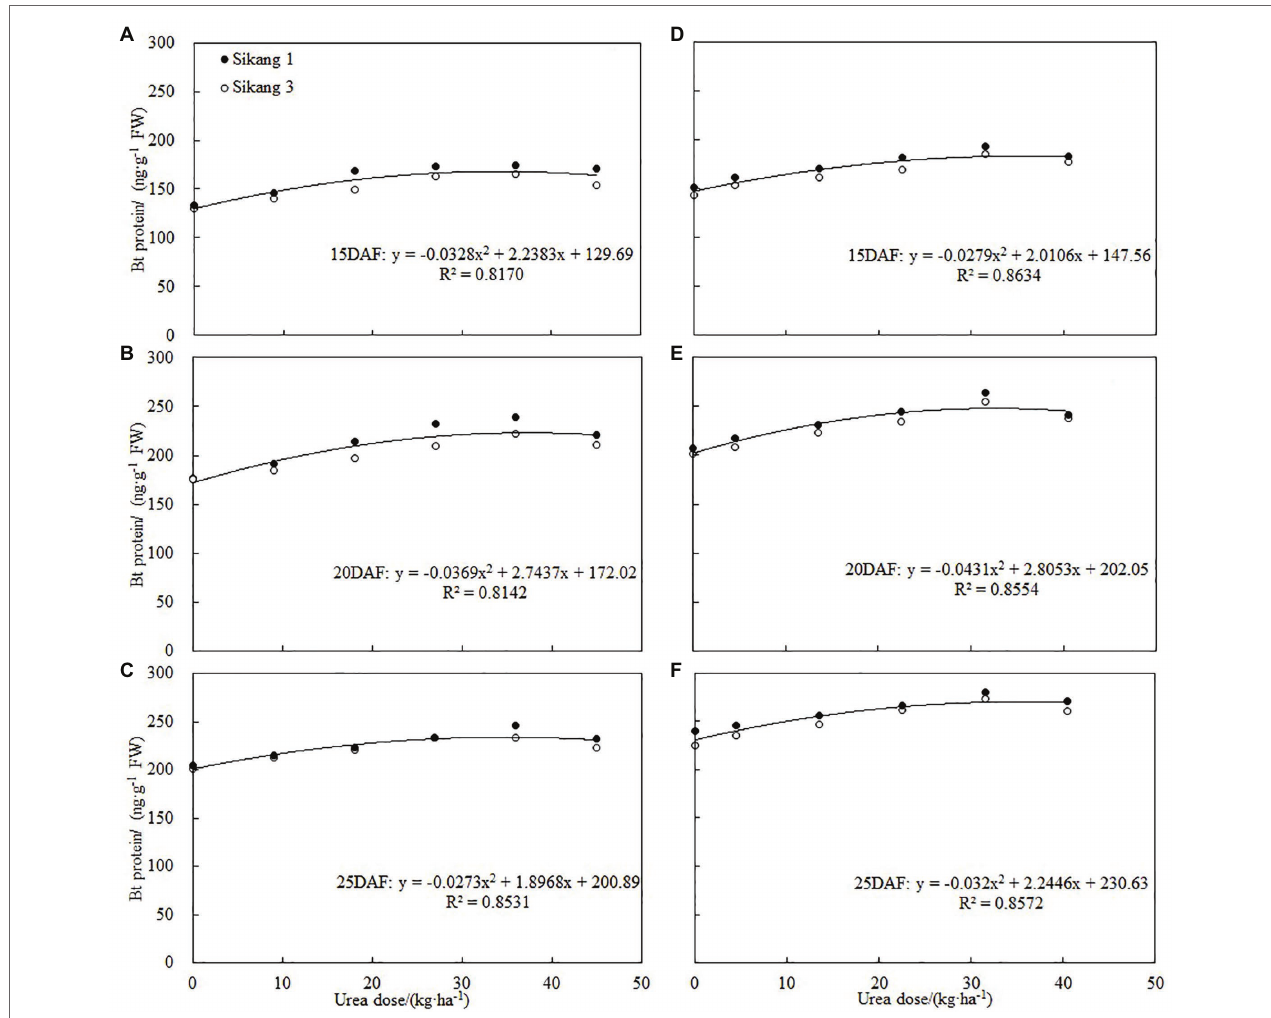
FIGURE 7 | Correlations between boll shell Bt protein content and urea dose at 15DAF (A,D) , 20DAF (B,E) , and 25DAF (C,F) in 2017 and 2018, respectively. FW represents the fresh weight of the sample, and DAF represents the abbreviation of “days after